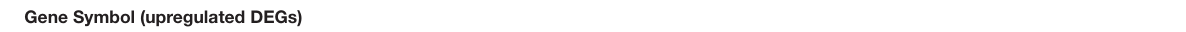
TABLE 2 | The common DEGs identified among GSE13576 and total set.